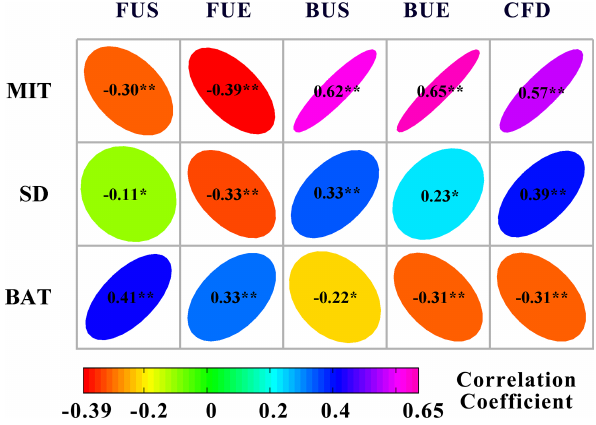
Figure 7. Correlation matrix between maximum ice thick- ness (MIT), snow depth (SD), and air temperature on bank (BAT) and lake ice phenology events with data from 120 stations. The as- terisks indicate the significance level of the correlation coefficients: ∗∗ means significant at 99% level ( p < 0 . 01), and ∗ means signifi- cant at 95% level ( p < 0 . 05).